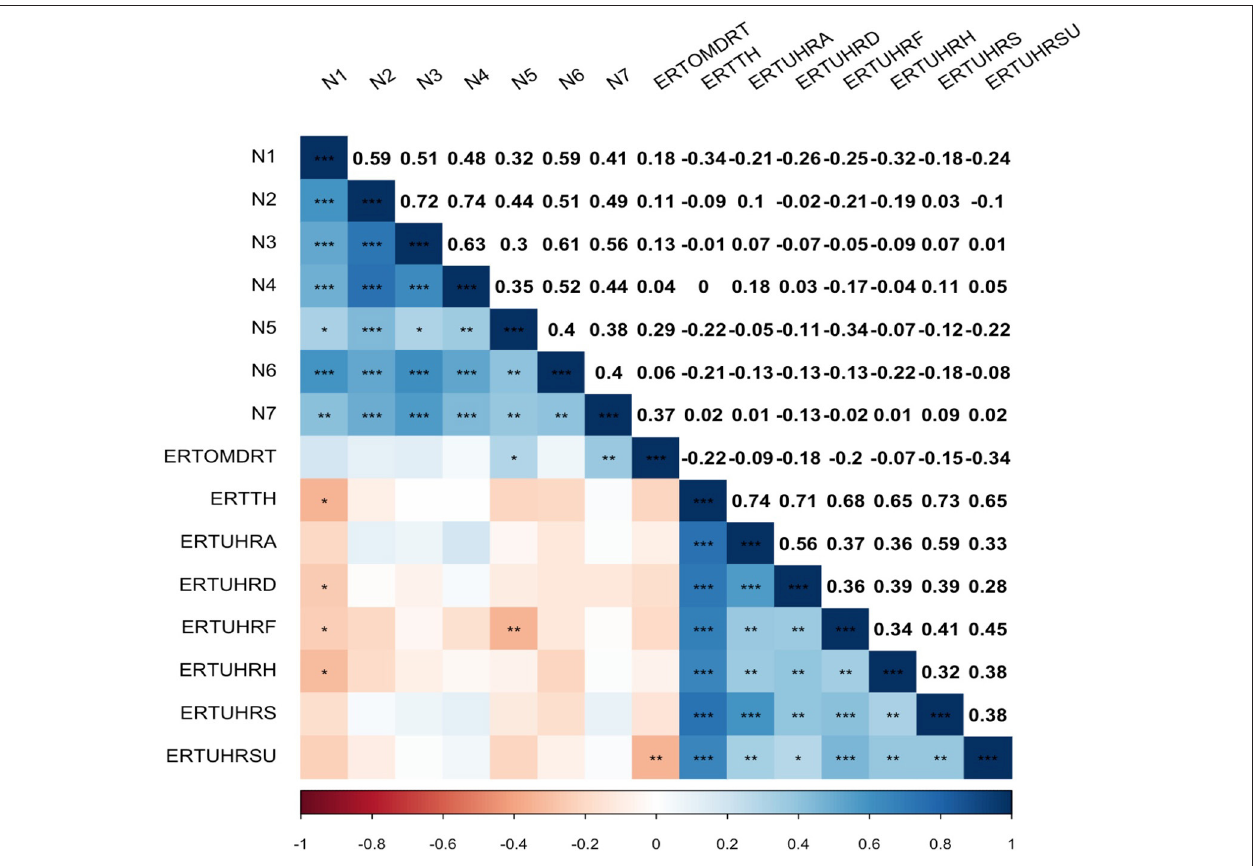
FIGURE 1 | Correlation Matrix of Positive and Negative Syndrome Scale (PANSS) Negative Scale and Emotion Recognition Test (ERT) key outcomes in form of a heat map with Pearson correlation coefficient and significance level with unadjusted p -values (***p < 0.001, **p < 0.01, *p < 0.05); N1, blunted affect; N2, emotional withdrawal; N3, poor rapport; N4, passive and apathetic social withdrawal; N5, difficulty in abstract thinking; N6, lack of spontaneity and flow of conversation; N7, stereotyped thinking; ERTOMDRT, the overall median reaction time to select an emotion; ERTTH, the total number of correct responses; ERTUHRA, the unbiased hit rate for the emotion anger; ERTUHRD, the unbiased hit rate for the emotion disgust; ERTUHRF, the unbiased hit rate for the emotion fear; ERTUHRH, the unbiased hit rate for the emotion happiness; ERTUHRS, the unbiased hit rate for the emotion sadness; ERTUHRSU, the unbiased hit rate for the emotion